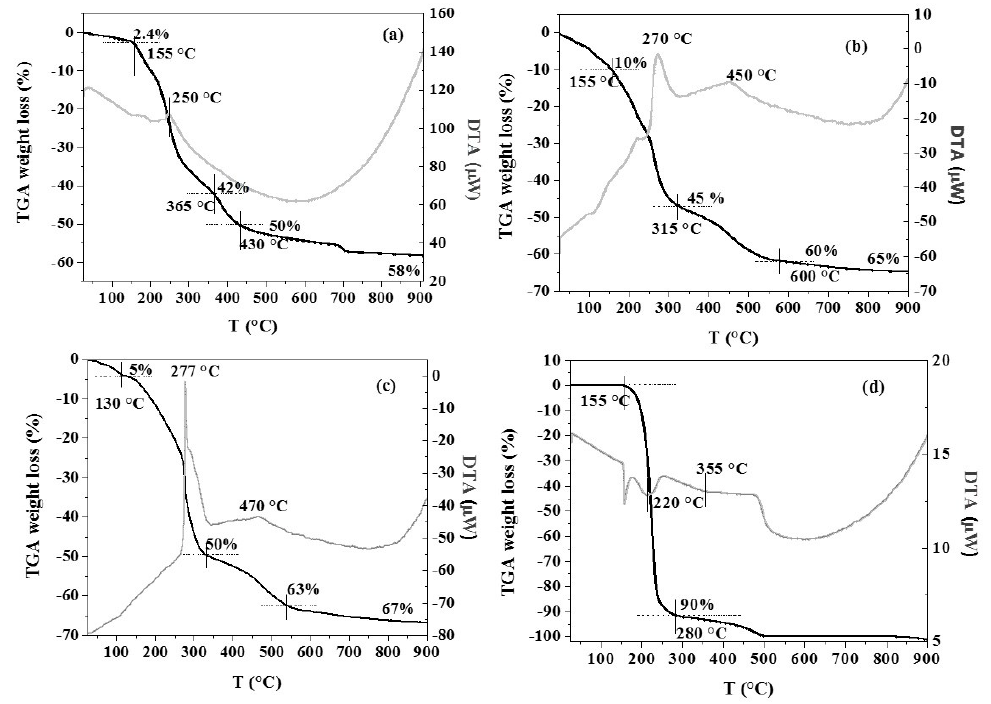
Figure 3. Differential thermal analysis (DTA) and thermogravimetric analysis (TGA) profiles registered under air for selected non-calcined precursor materials (dried gel—catalysts before calcination treatment): ( a ) LM0.8, ( b ) LM1.2, ( c ) LM2, and ( d ) pure CA, used as a reference.